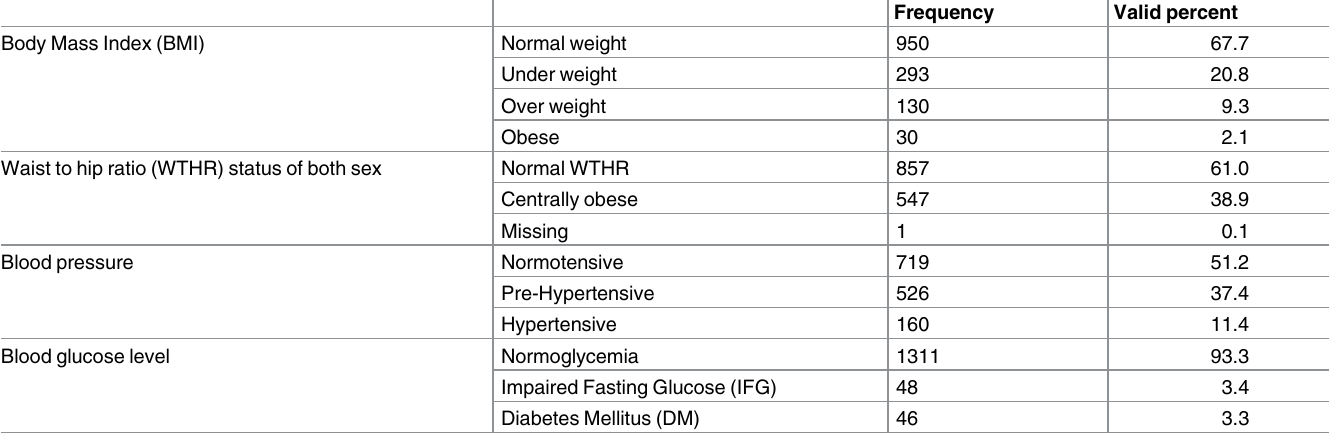
Table 2. Anthropometric and other body measurement results of participants (N = 1405). Body Mass Index (BMI)